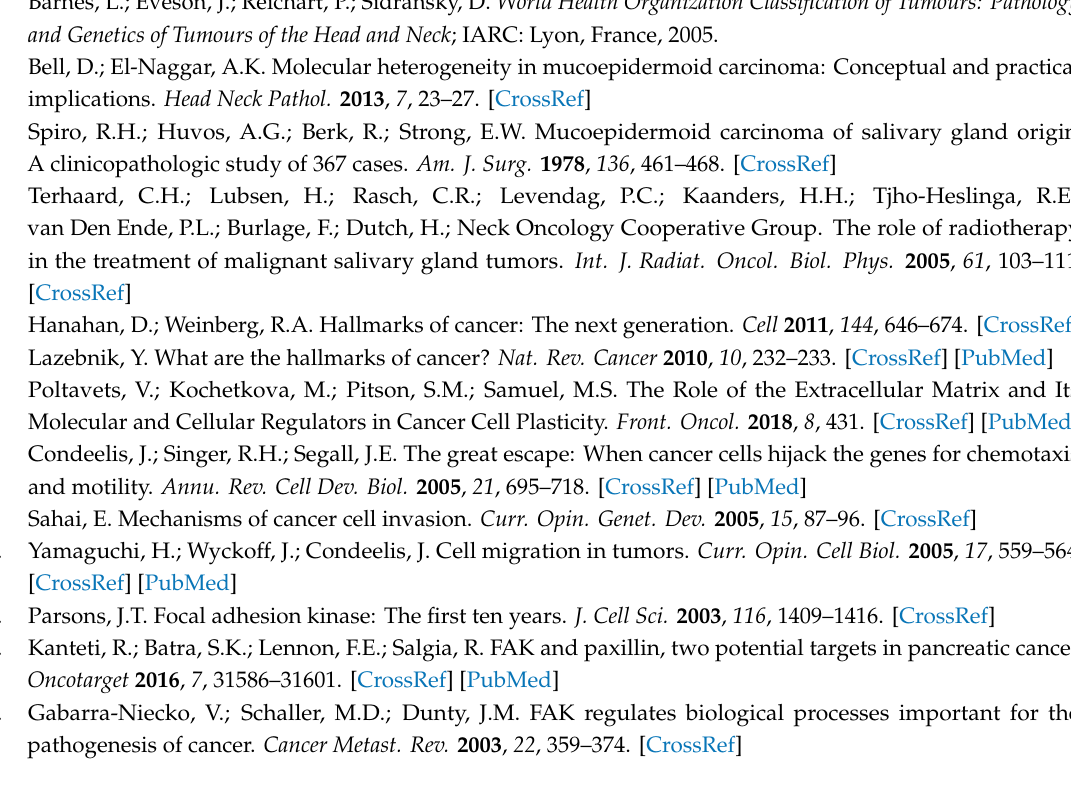
Figure S1: E ff ects of NCTD on apoptosis in YD-15